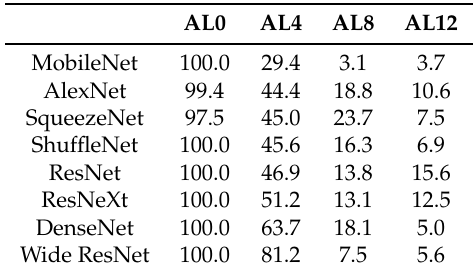
Table 7. Underwater AL0 inter-set test. Architectures trained on ALO and tested against all AL data sets.